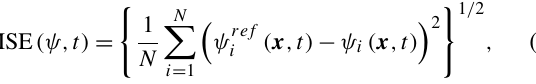
Table 1. The root-mean-square error (RMSE) of the solution